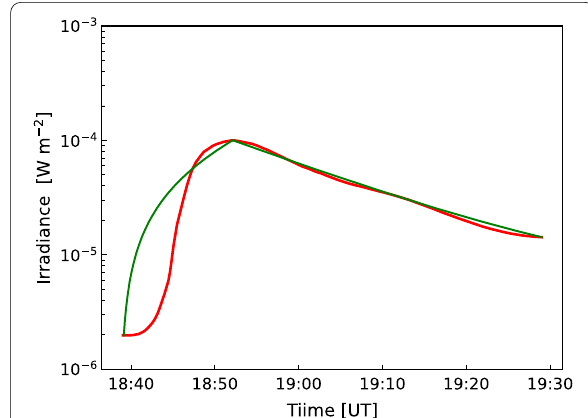
Fig. 4 Example of fit GOES/XRS-B light curve for the M9.9-class flare on January 1, 2014. The observed (red) and fit (green) light curves during the M9.9-class flare on January 1, 2014 using the Gauss– Newton method